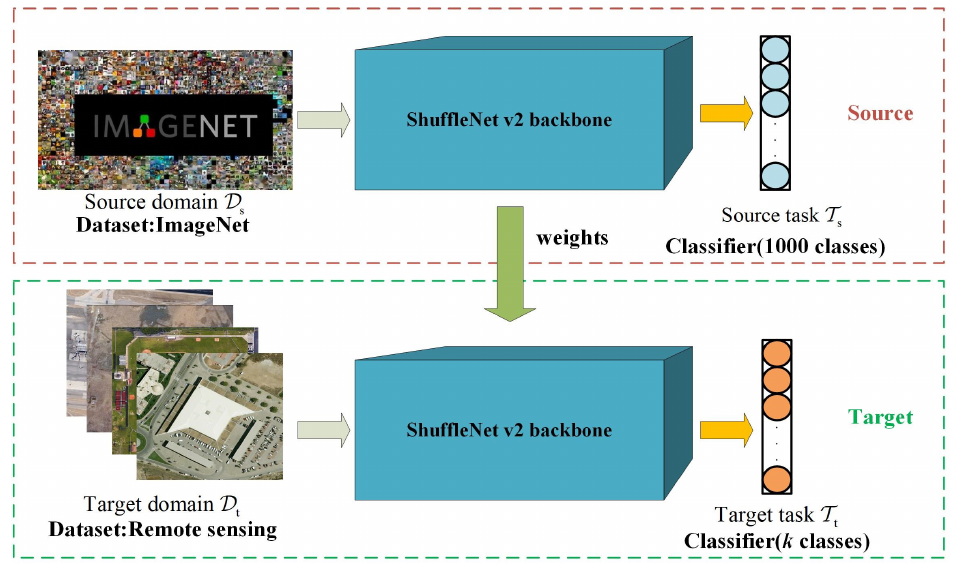
Figure 4. Transfer learning